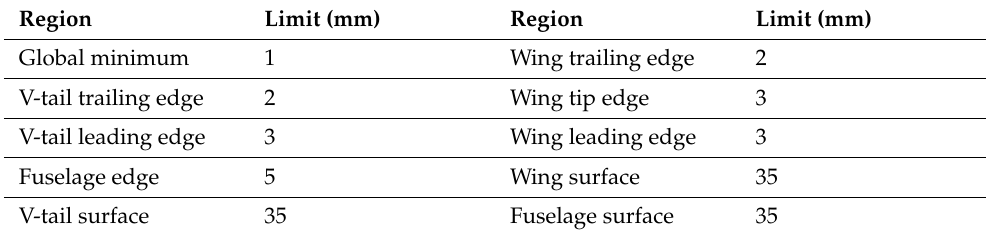
Figure 7. Mesh of the fuselage and wing surfaces. Table 3. Grid size of the aircraft.